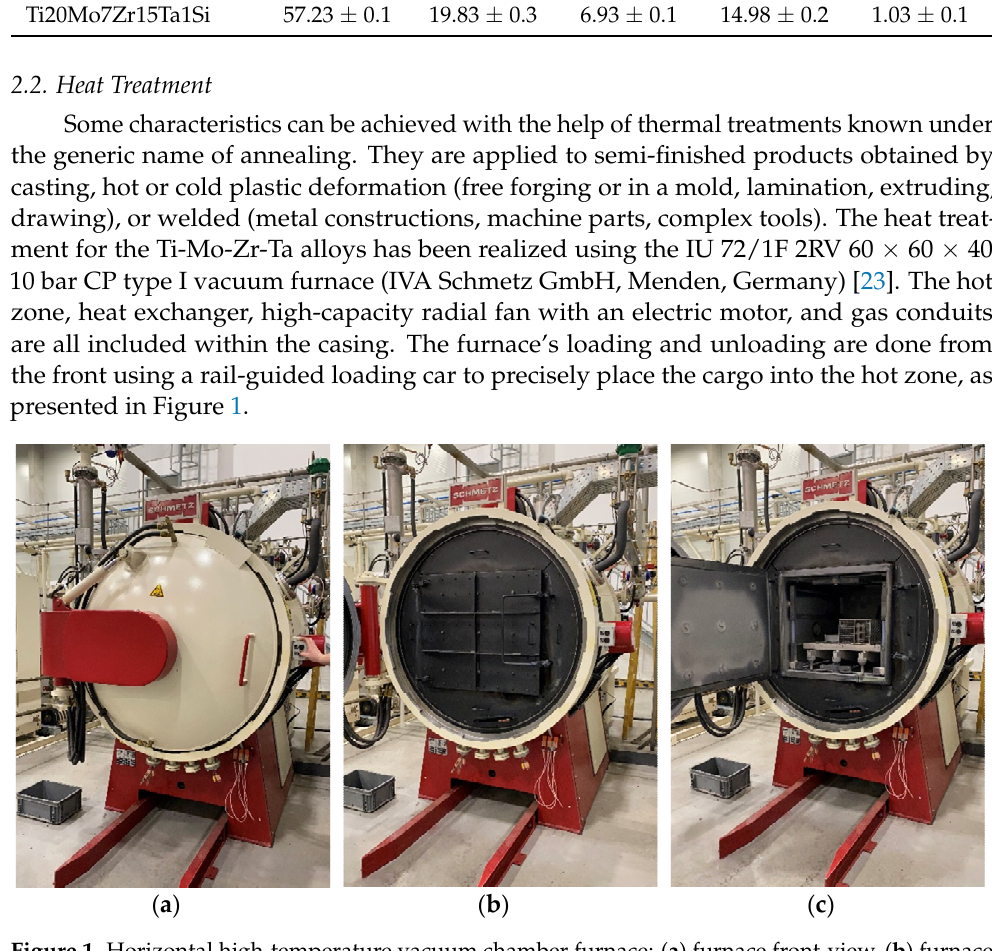
Figure 1. Horizontal high-temperature vacuum chamber furnace: ( a ) furnace front-view, ( b ) furnace set-up, ( c ) furnace chamber and sample holder.